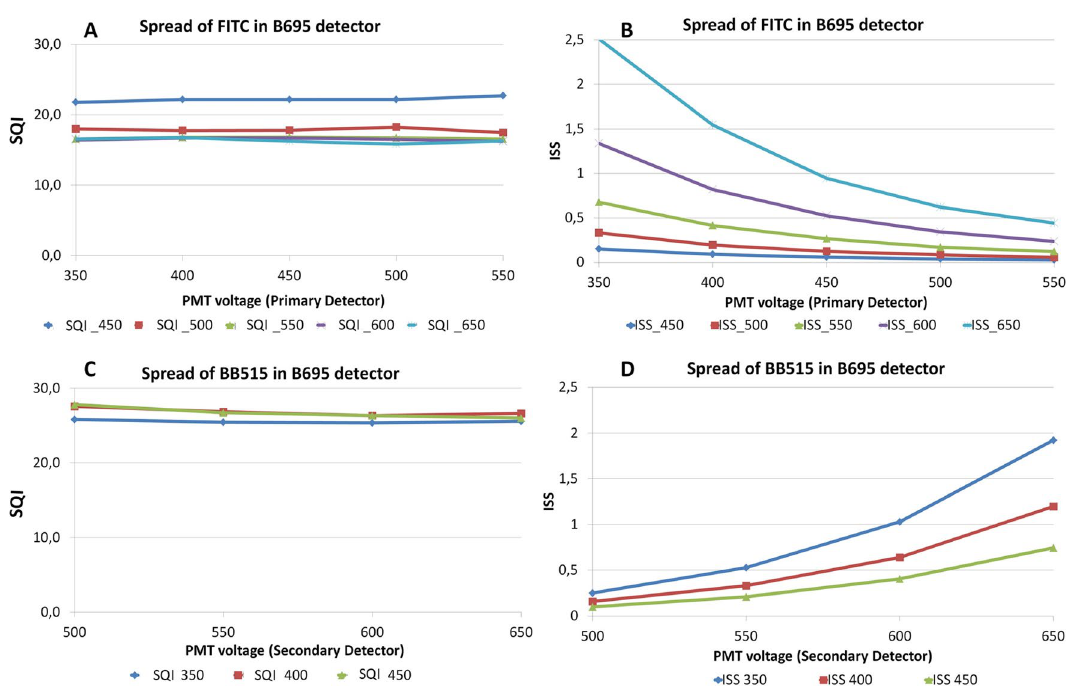
Figure 3. Effect of detector settings on SQI and ISS: In ( A , B ) we have only changed the PMT voltage for the primary detector. SQI remains same but ISS dropped with increase of voltage. In ( C , D ), we only changed PMT voltage for secondary detector. SQI again remain same but ISS increased with